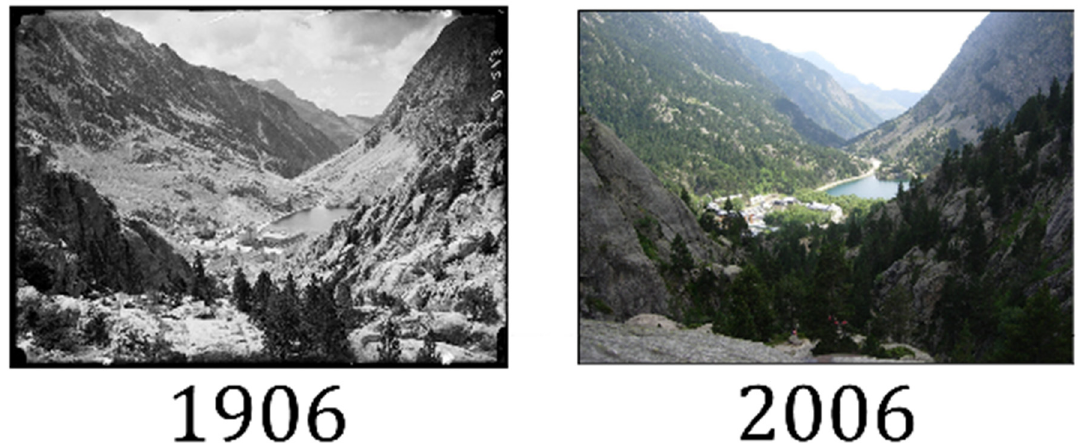
Figure 2. The study area and surroundings in 1906 and 2006, showing the reforestation that has occurred in the Pyrenees.